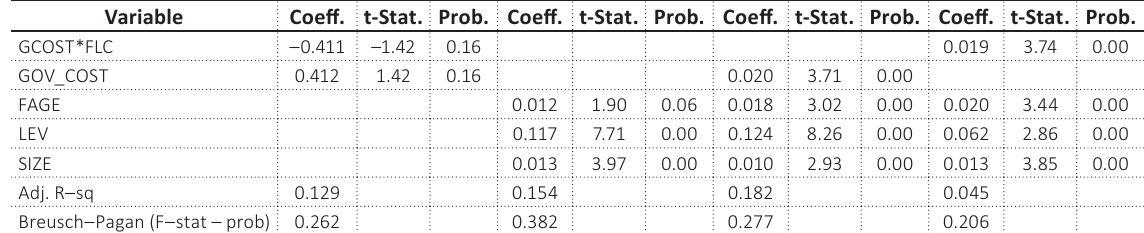
Table 8. FGLS results for aggregate